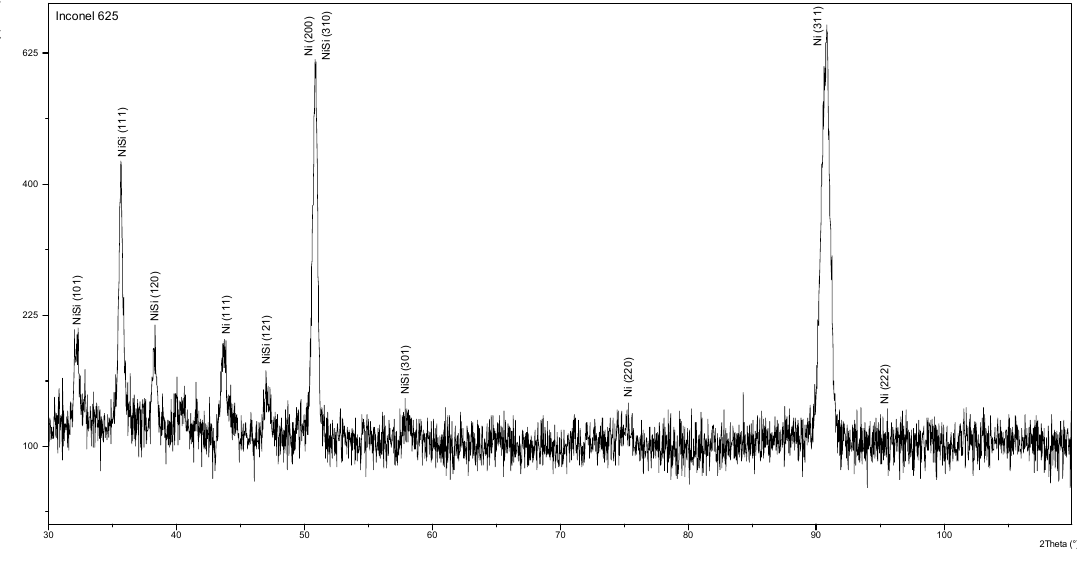
Figure 8. Examples of X-ray spectrum of overlay weld in the surface of Inconel 625 superalloy layer obtained in the process of plasma powder transferred arc surfacing (sample P2).